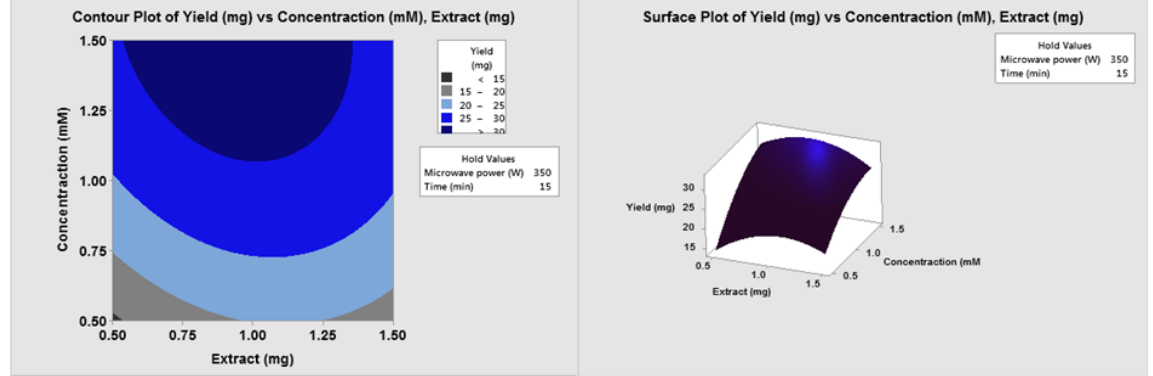
Figure 1. Fungal biomass (extract) and total metal concentration effect on NP yield.